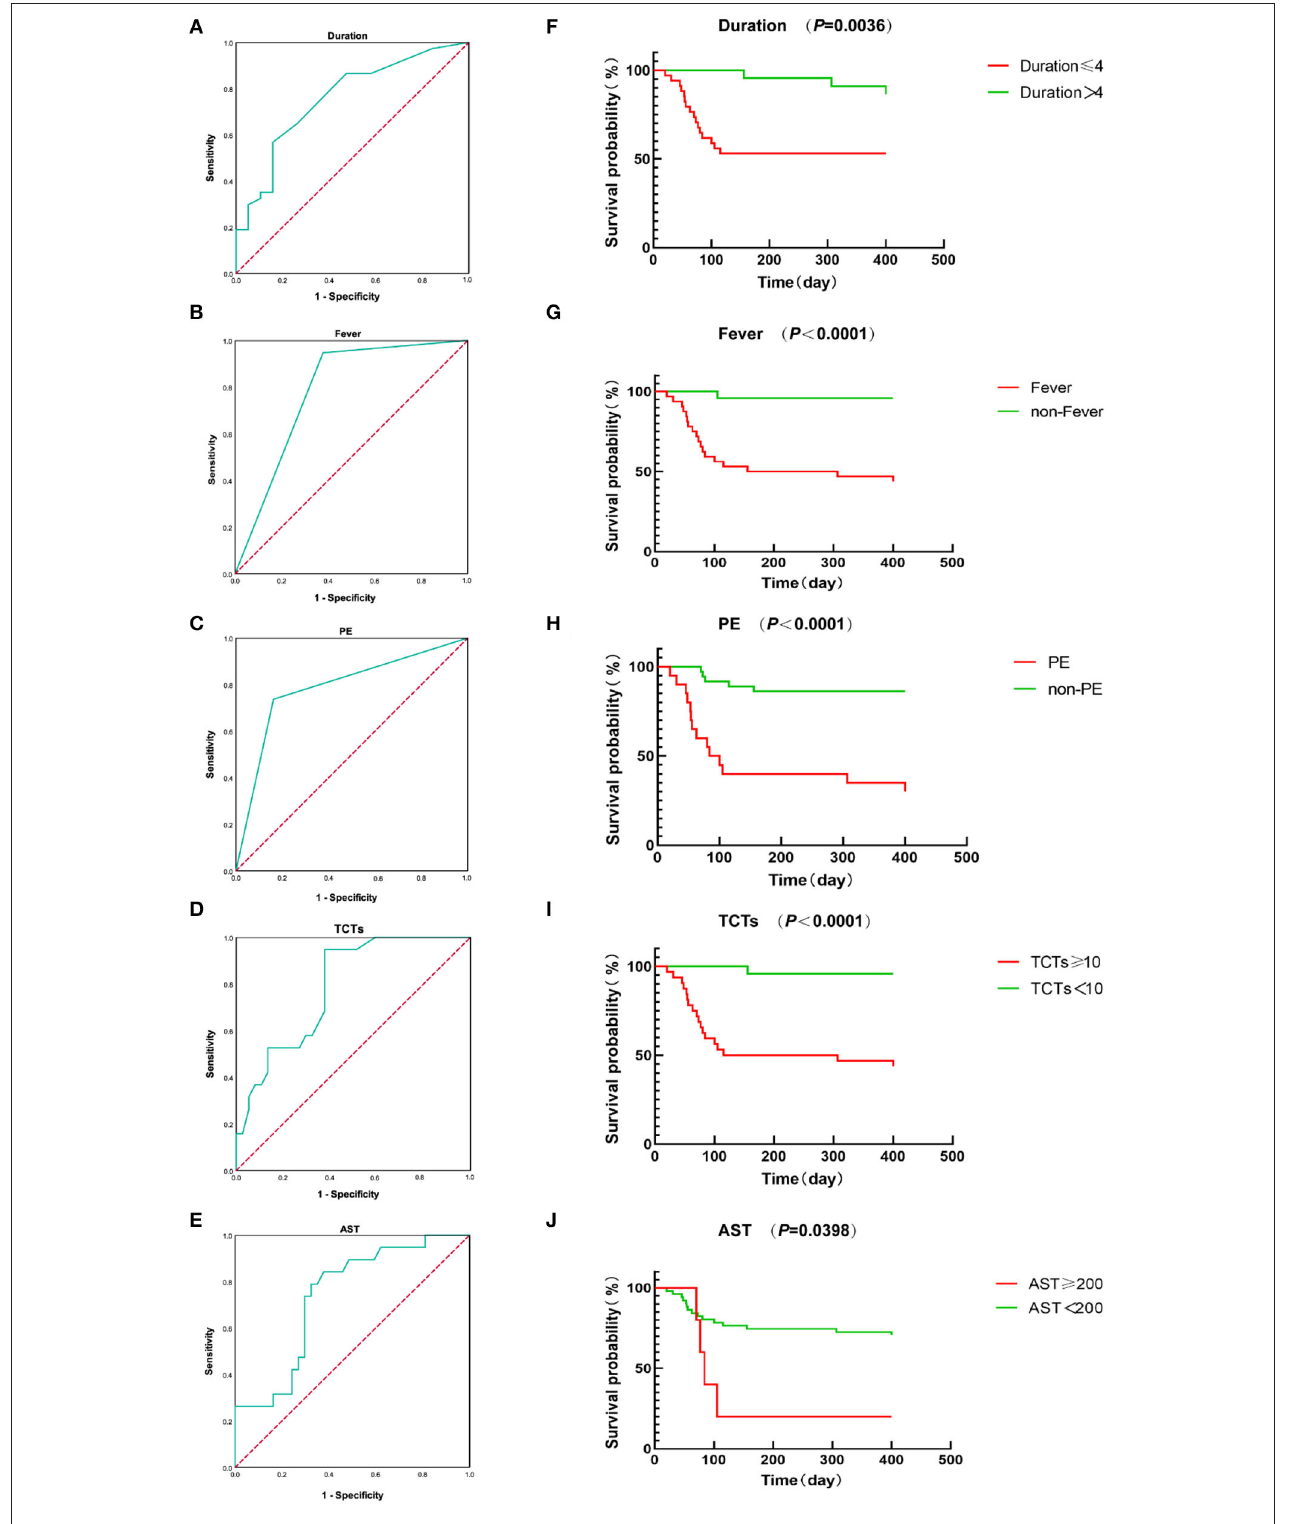
FIGURE 2 | (A–E) ROC curves of duration, fever, PE, TCTs, and AST. (F–J) Kaplan-Meier survival curves of duration, fever, PE, TCTs, and AST.